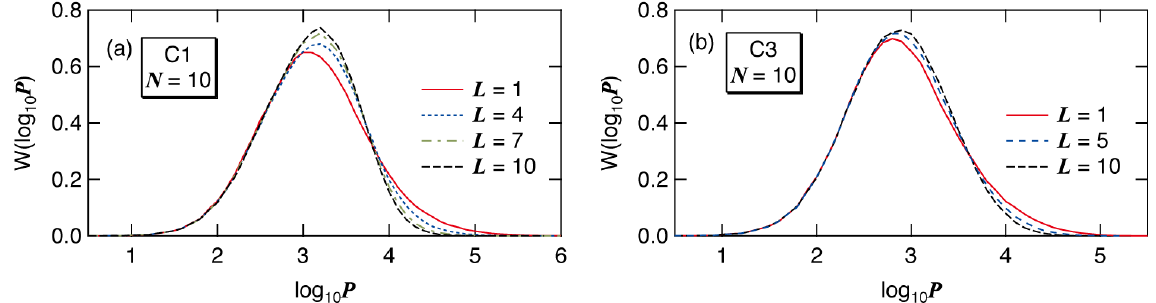
Figure 13. MC simulation results for the weight fraction distribution, plotted as a function of log 10 P , W(log 10 P ) of the polymers formed for conditions ( a ) C1 and ( b ) C3, with N =